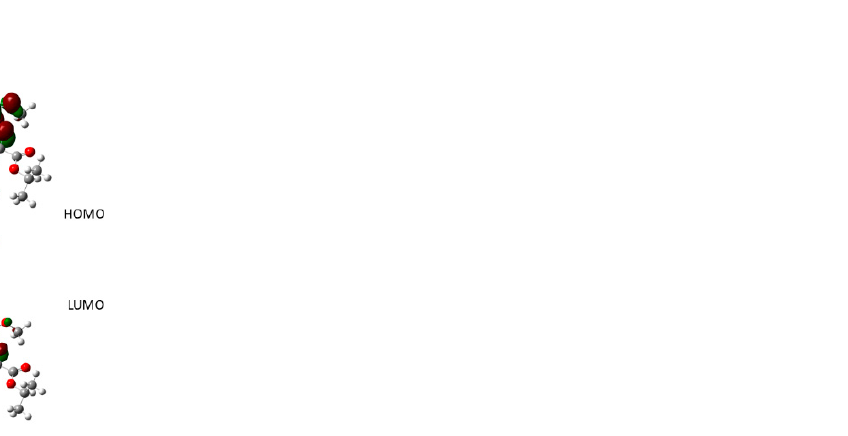
Figure 5. Highest occupied molecular orbital (HOMO) and lowest unoccupied molecular orbitals (LUMO) of 3e .